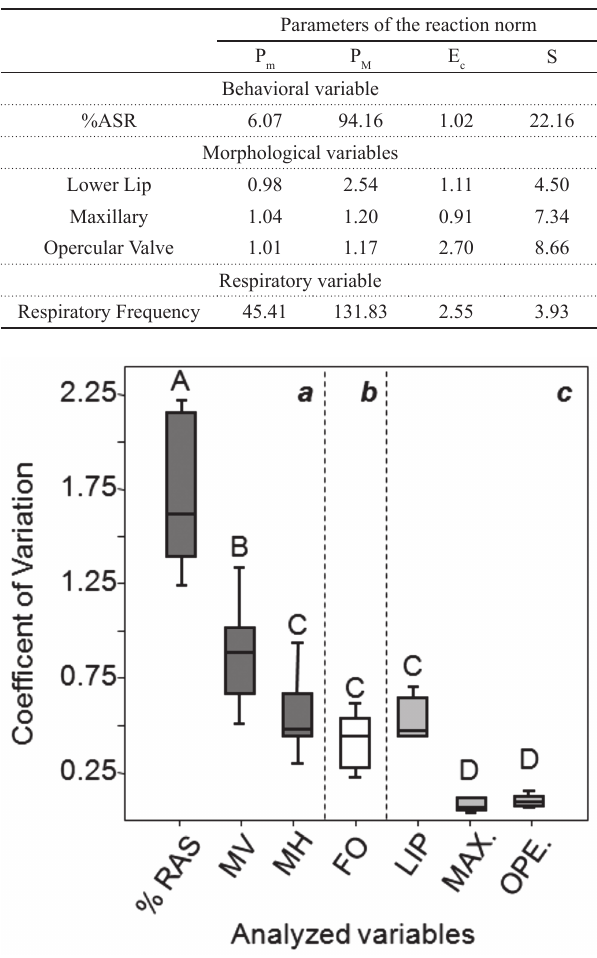
Fig. 5. Comparisons of plasticity among behavioral (a), respiratoy (b) and morphological traits (c) of Piaractus mesopotamicus as measured by the coefficient of variation (CV) across the DO gradient. Capital letters above box plots indicate groups in multiple comparison Tukey’s tests after a one way ANOVA. Names of traits as defined in the